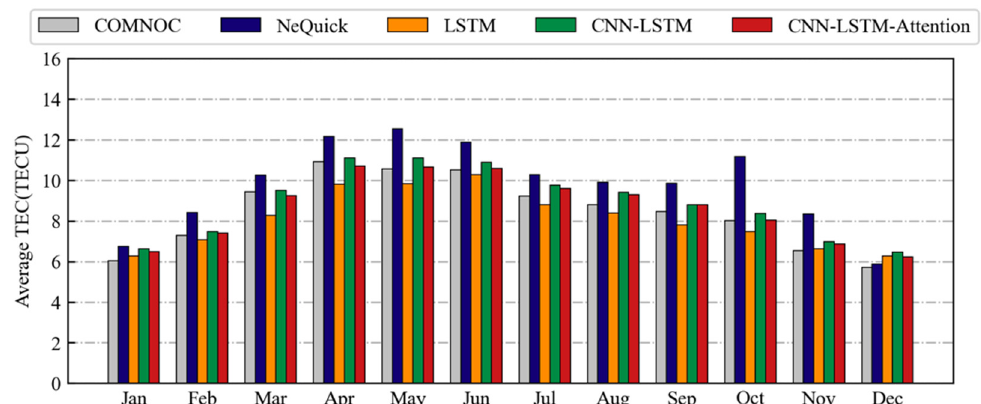
Figure 8. The RMSE and R 2 of NeQuick (blue bars), LSTM (yellow bars), CNN-LSTM (green bars), and CNN-LSTM-Attention (red bars) models from 12 months in the test set. ( a , b ) are RMSE and R 2 , respectively.